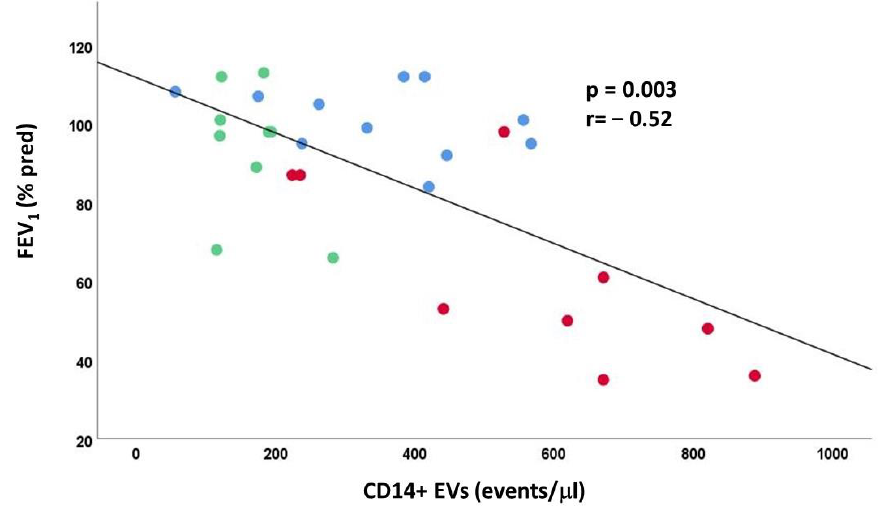
Figure 5. Correlation of lung function (FEV1 pred%) with macrophages derived-EVs. Red circles: Smokers with COPD; Lightly blue circles: Smokers without COPD; Green circles: Non-smokers. Spearman rank correlation (r = − 0.52 and p = 0.003).